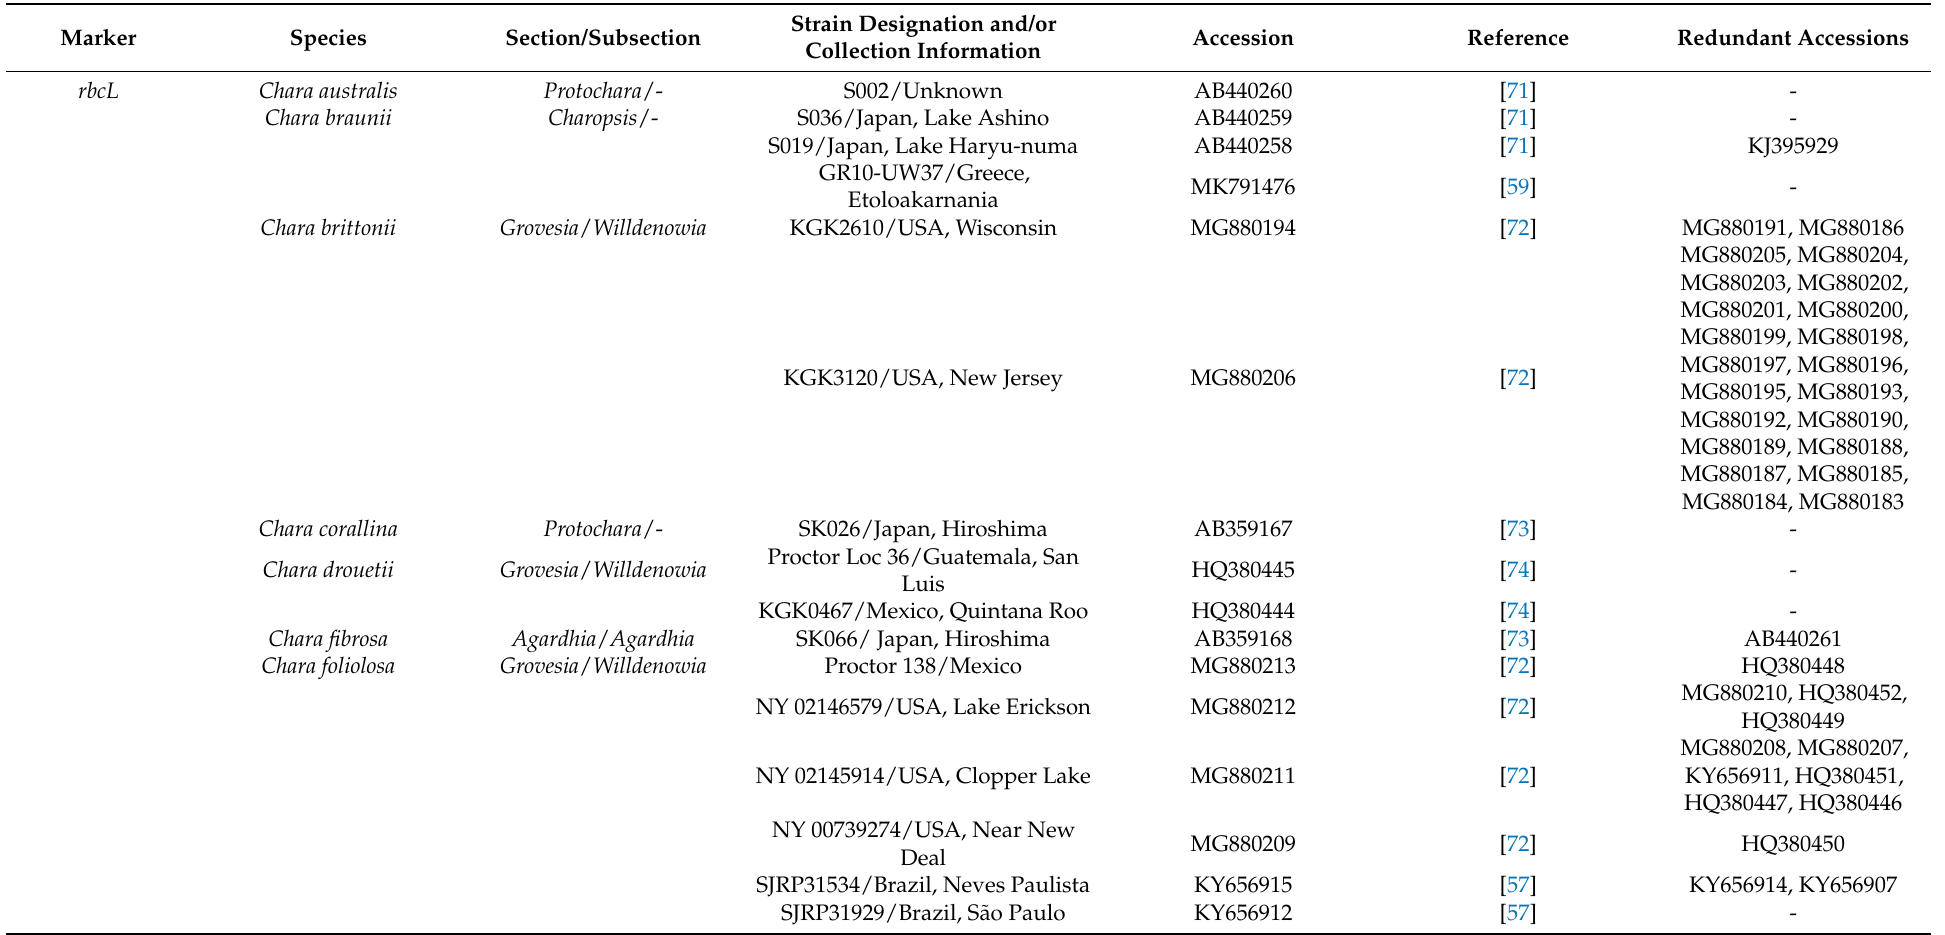
Table 1. Sample list of specimens used for phylogenetic analyses. Indicated are the accession numbers of the haplotypes (=non-redundant genotypes) downloaded from the GenBank. Information about the section and the subsection of the species is given in the third column [24,29,53] and identical sequences are given in the last column. n|a = not